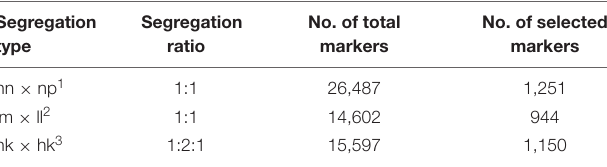
TABLE 5 | Number of candidate SNP markers used for constructing a linkage map for Pacific